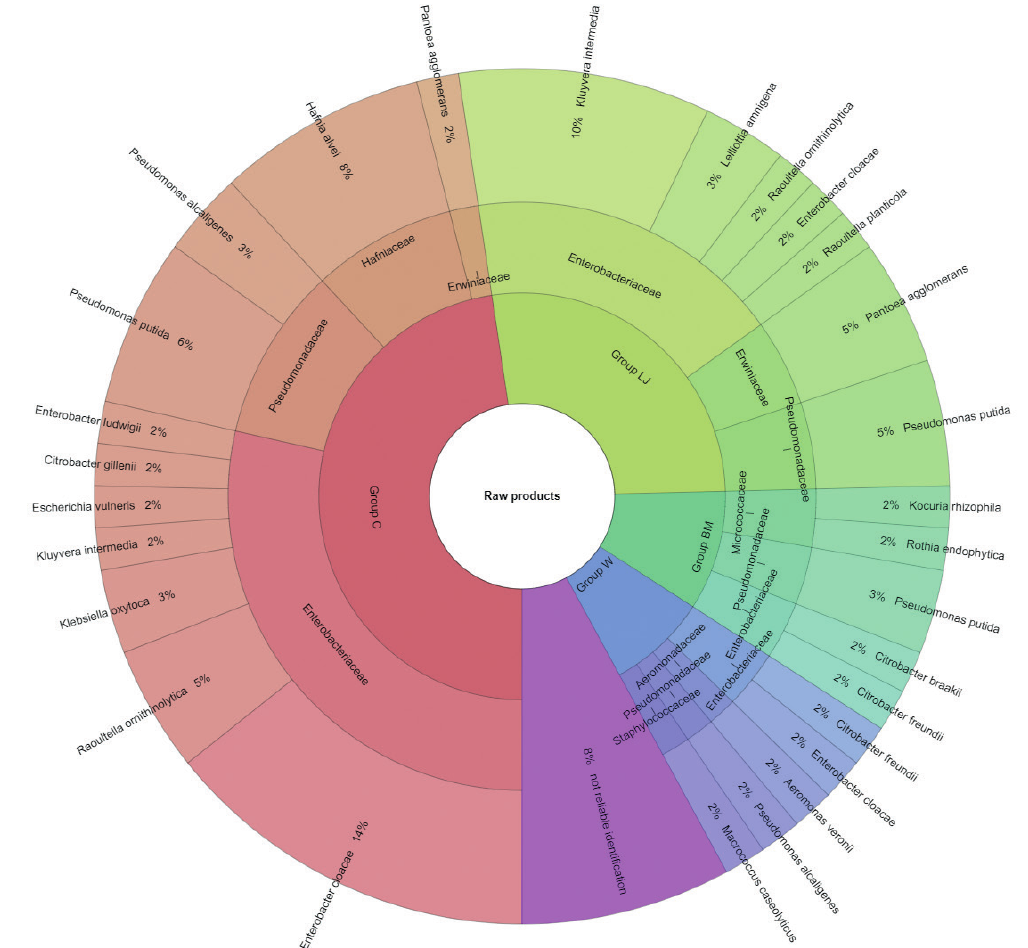
Figure 1. Identified species and family of bacteria in the raw